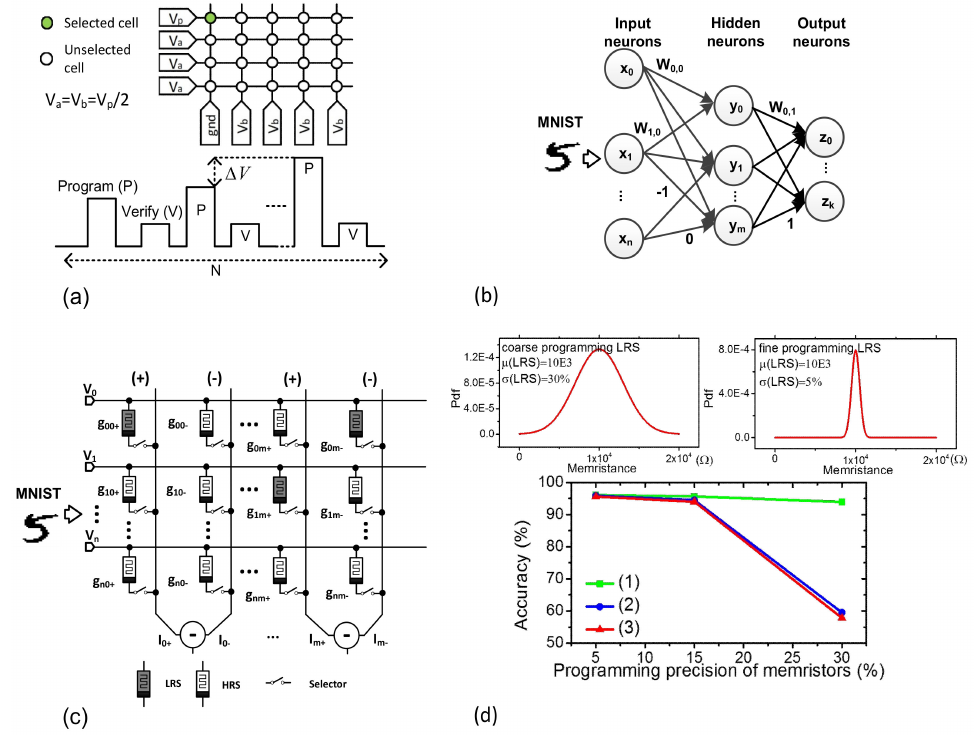
Figure 2. ( a ) The program-verify scheme for programming memristors. ( b ) The diagram of multiple-layer neural networks. ( c ) The schematic of binary-memristor-based networks. ( d ) The memristance distributions on Low Resistance State (LRS) cells with the percentage σ = 30% and 5% are shown in the upper region, respectively. σ = 30% and σ = 5% mean the memristor programing precision is coarse and fine, respectively. ‘pdf’ means the probability density function. The network accuracy of Modified National Institute of Standards and Technology (MNIST) data-set while varying the programming precision is shown in the lower. (1) The programming precision of HRS is changed from 5% to 30%, while maintaining the LRS precision is 5%. (2) The programming precision of LRS is changed from 5% to 30%, while maintaining the HRS precision at 5%. (3) The programming precision of both HRS and LRS is changed from 5% to